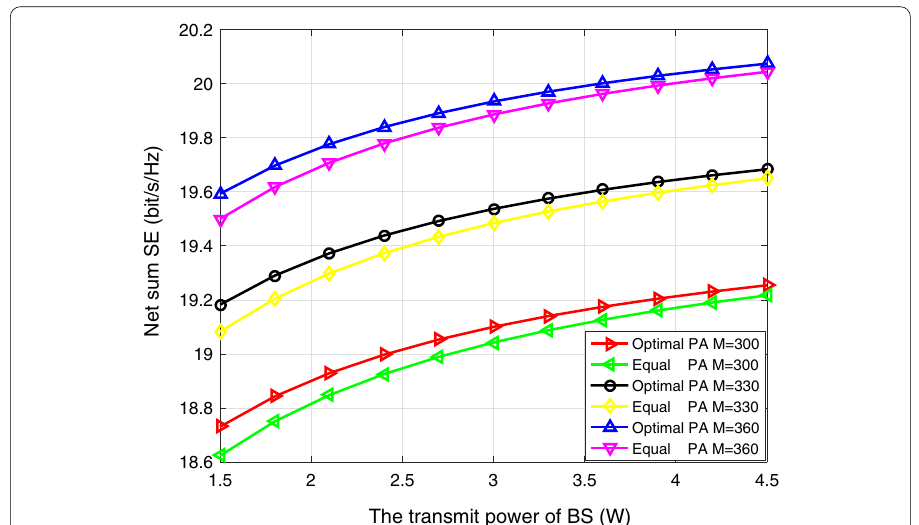
Fig. 9 Net SE of each terminal versus the transmit power of BS, where τ = 0.015 , α = 0 and (cid:31) = [ 0.5,0.5,0.5 ] T